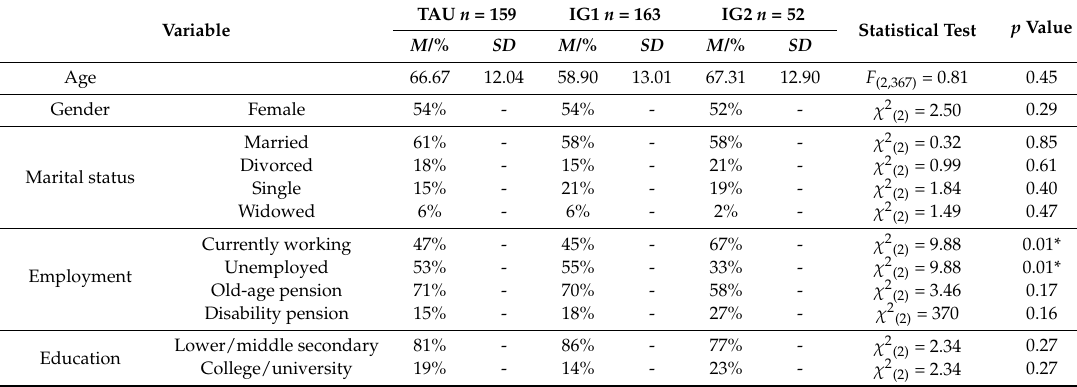
Table 1. Descriptive details for demographic variables for the patient population and comparisons across treatment groups, n =